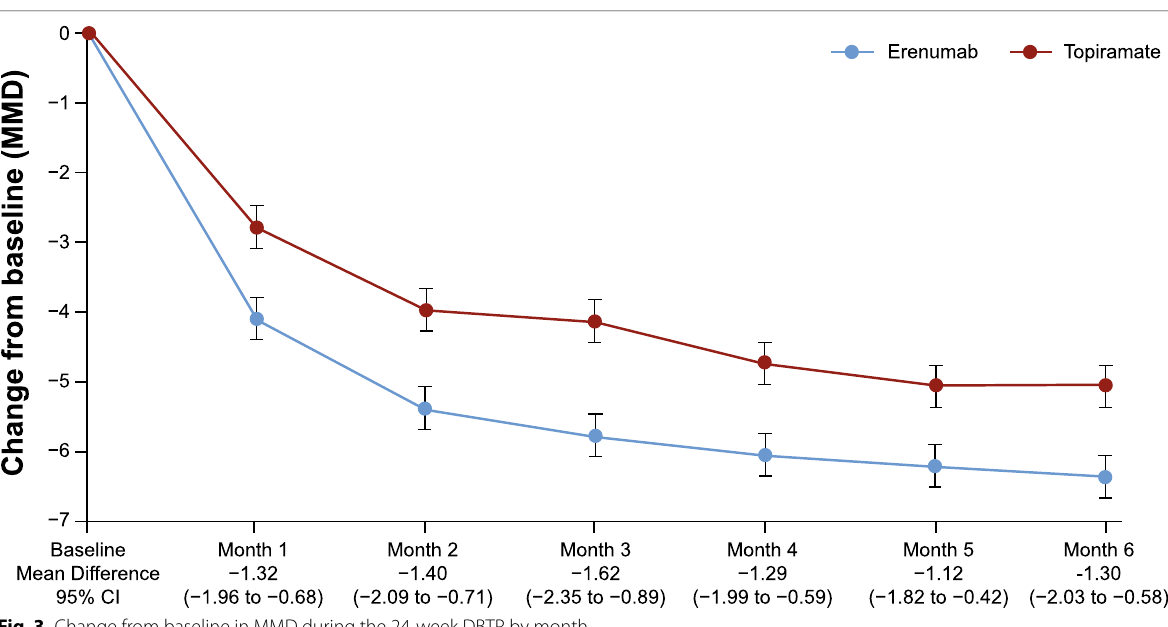
CI Confidence interval, N Total number of patients, N ′ Number of patients in the analysis, SD Standard deviation, SE Standard error, DBTP Double-blind treatment phase, MMD Monthly migraine days